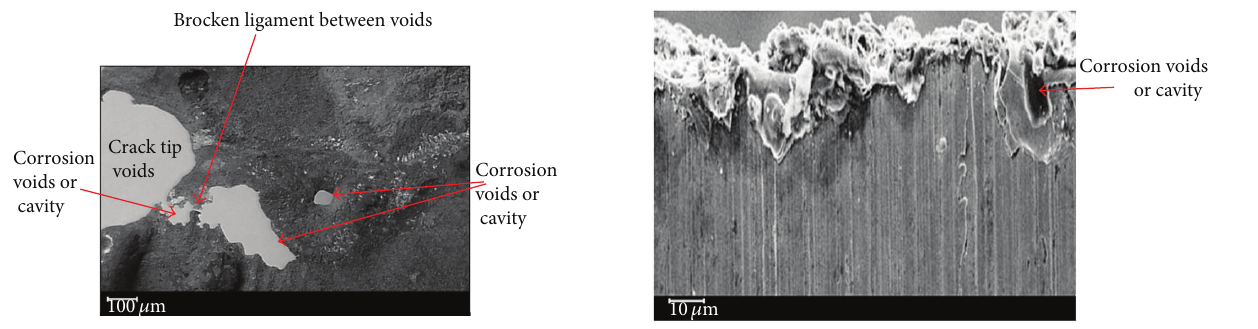
Figure 9: SEM image of a cross-section rupture of the collecting plate (corrosion pits near fracture